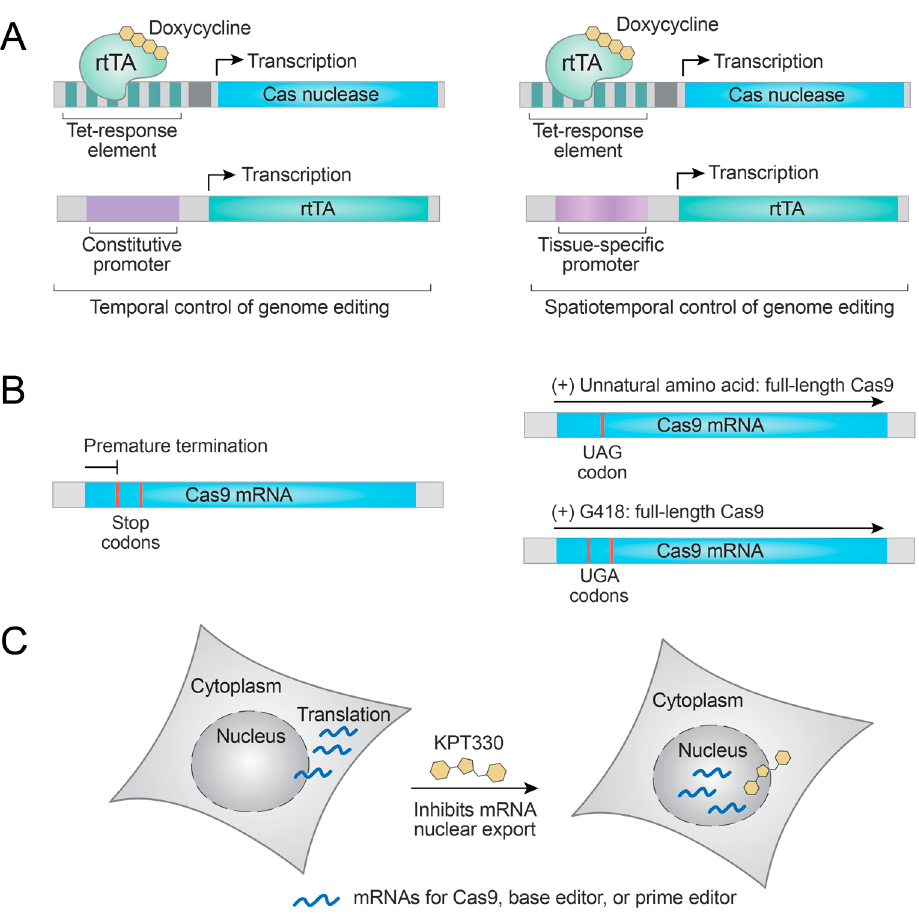
Figure 2. Examples of the small-molecule control of Cas nuclease expression. ( A ) Transcriptional control of Cas nuclease expression by doxycycline. Temporal or spatiotemporal control of the nuclease expression can be achieved by employing appropriate promoters for rtTA expression. ( B ) Small-molecule control of Cas9 translation using stop-codon read-through strategies. ( C ) Small-molecule control of mRNA export to modulate the expression of genome-editing machinery.